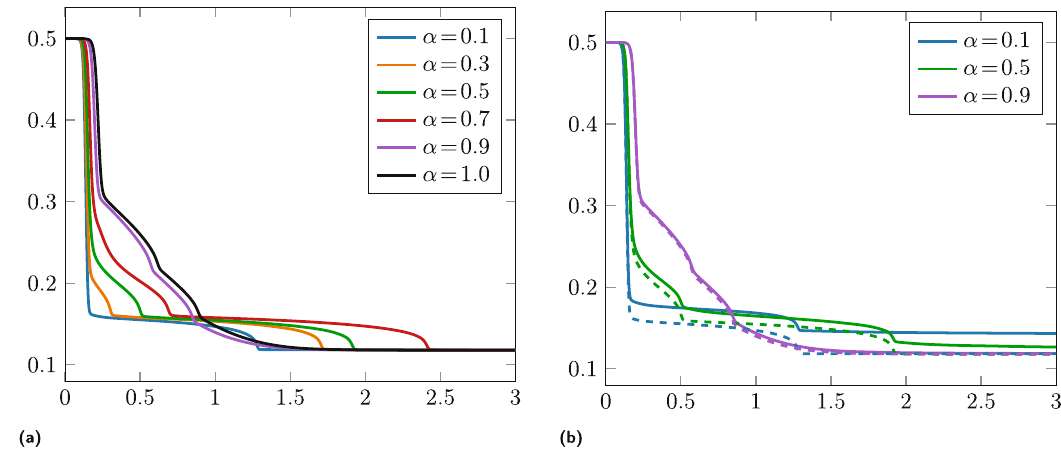
Figure 3: ( a ) Evolution of the standard energy (cid:3) for { } ∈ α 0.1, 0.3, 0.5, 0.7, 0.9, 1.0 and [ ] ∈ t 0, 3 . ( b ) Comparison of